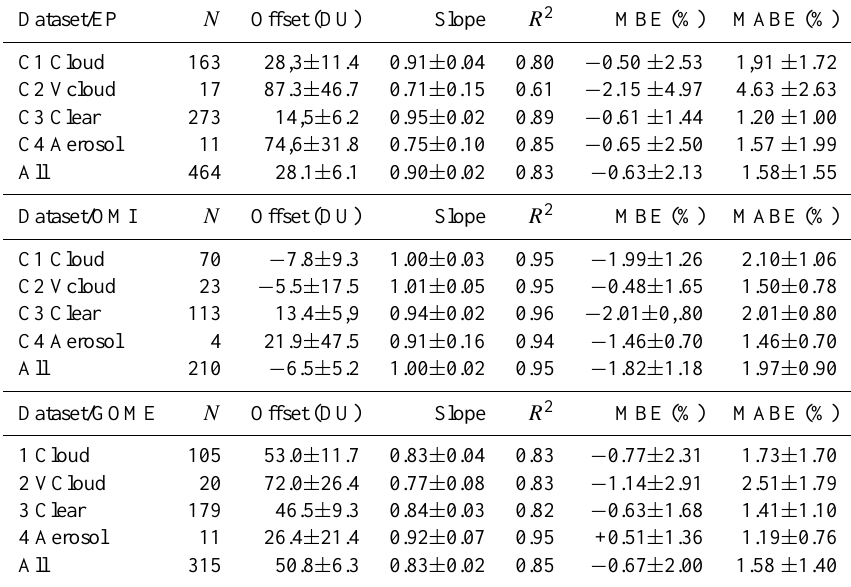
Table 2. Parameters obtained in the correlation analysis between different TOC satellite-Brewer datasets over Madrid in the months of June, July and August. Comparisons EP-TOMS are over the period 1996–2001, OMI are over the period 2006–2008 and GOME over the period 1996–2008 whenever a data exists to be matched with Brewer data. N is number of data pairs. Offset (in Dobson Units) and slope (without units) are the values of the parameters of the linear adjustment, R 2 is the value of squared correlation coefficient, MBE is the Mean Bias Error and MABE is the Mean Absolute Bias Error. C1 means · ”cloudy” days as selected by cluster classification described at the text, C2 means “very cloudy” days, C3 means “clear” days and C4 (high) “aerosol” (load)